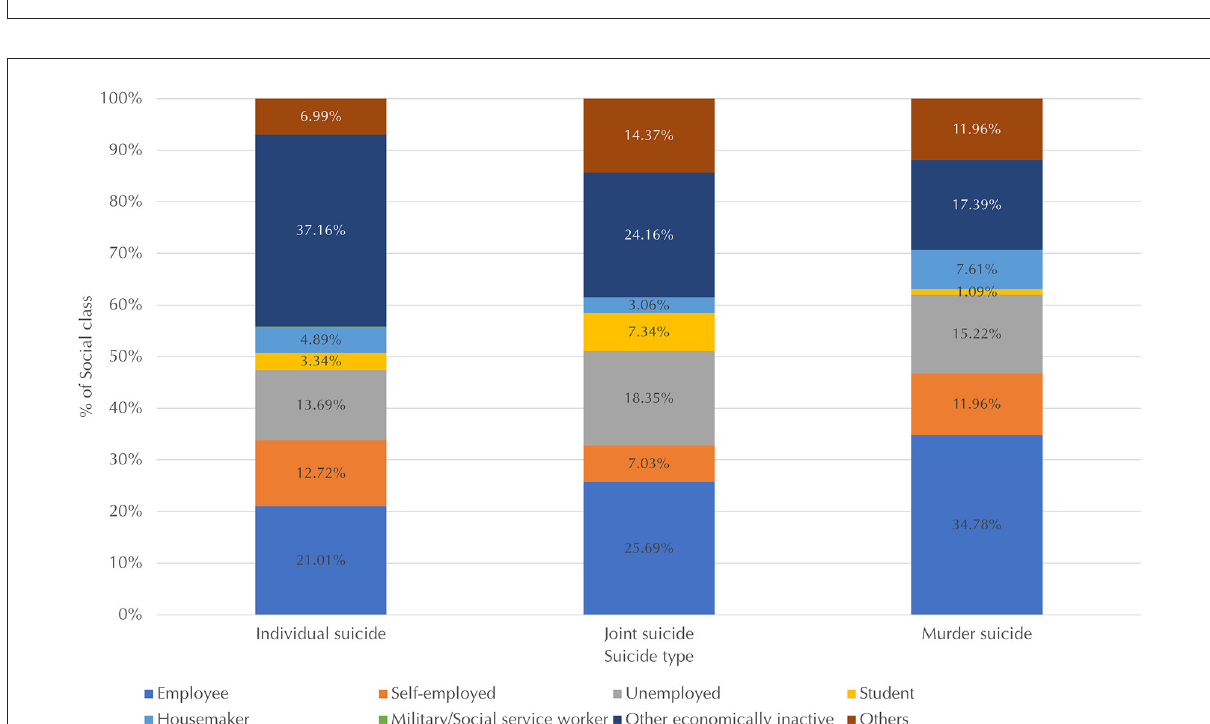
FIGURE3 Distribution of social classes (measured by employment status) across suicide types. Data for military or social service workers, which accounted for <1% of victims for each suicide type, are not shown due to limited